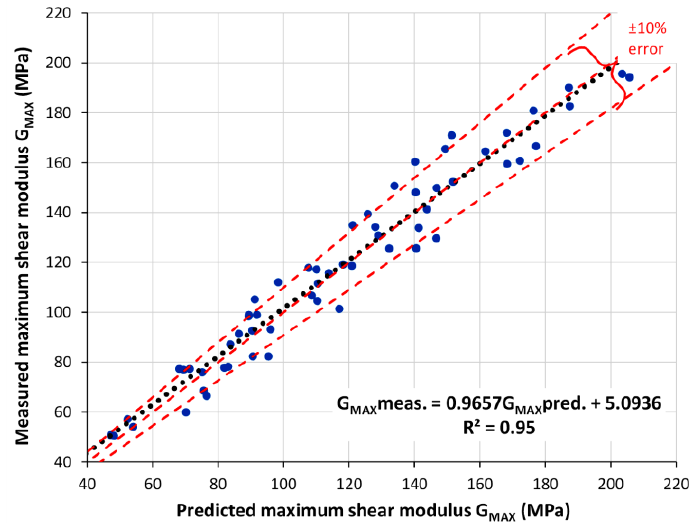
Figure 5. Measured versus predicted by authors’ equation maximum shear modulus (G MAX ) values.